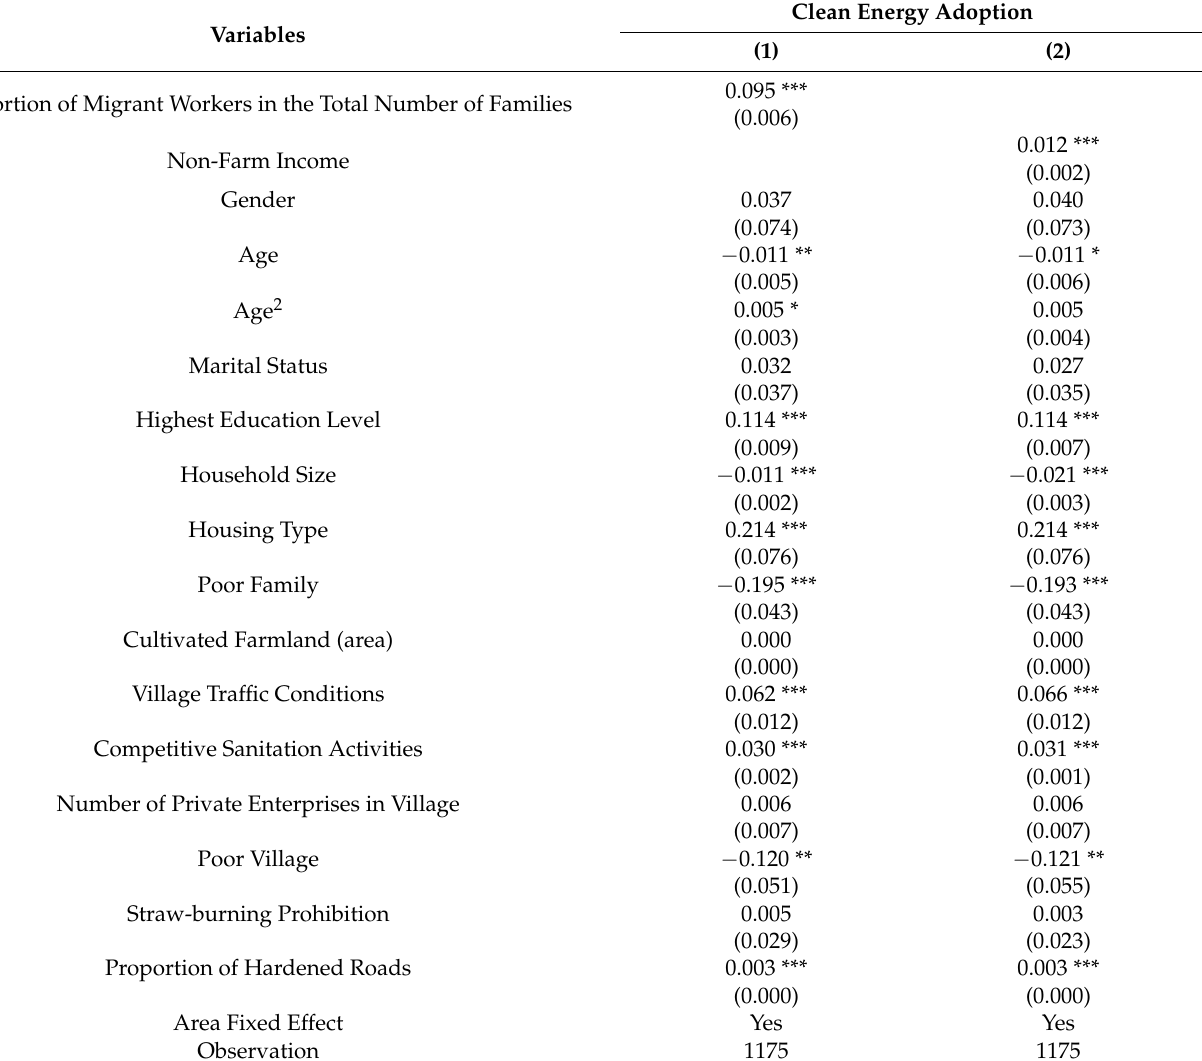
Table A3. Robustness Checks: Proportion of Migrant Workers and Non-Farm Income.